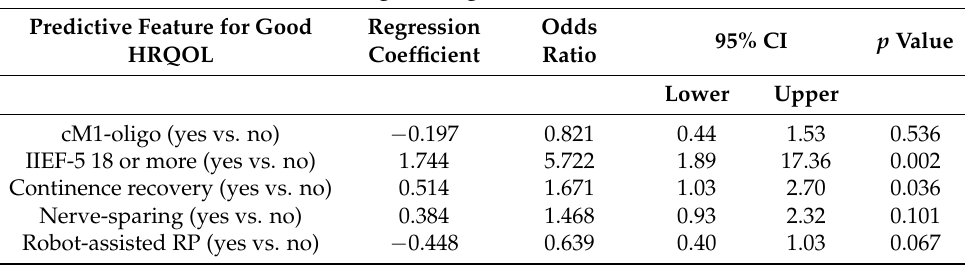
Table 4. Multivariable analysis assessing the primary endpoint good general HRQOL (defined as GHS of ≥ 70). Bold values indicate p -values < 0.05 and were considered statistically significant. Net change to preoperative status is presented, HRQOL: health-related quality of life; IIEF-5: International Index of Erectile Function; RP : Radical prostatectomy GHS: Global-Health status according to the European Organization for Research and Treatment of Cancer quality of life questionnaire-Cancer